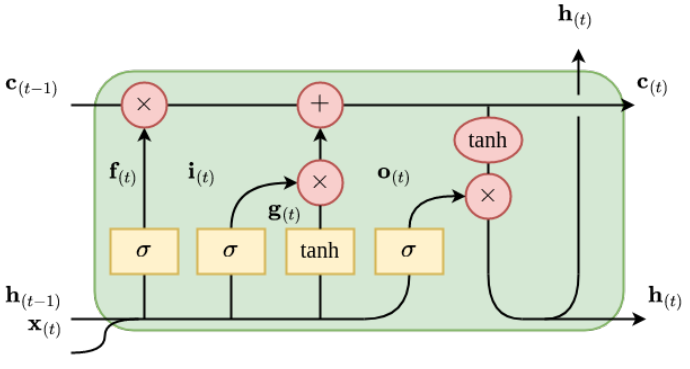
Figure 4. Representation of an LSTM